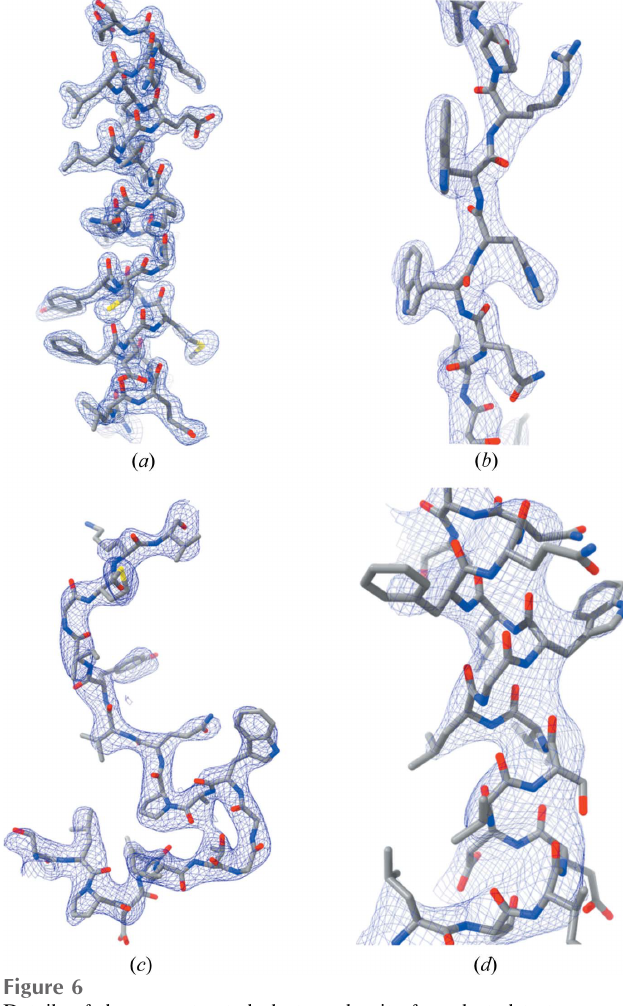
produces a single cluster of size 10, from a total of 20 runs. As imposed by the distance threshold, the phase sets within this cluster are all very similar (sample circular variance = 0.20, Table 1). The 10 members of the cluster correspond to the true solution, and have mean differences from the model phases of